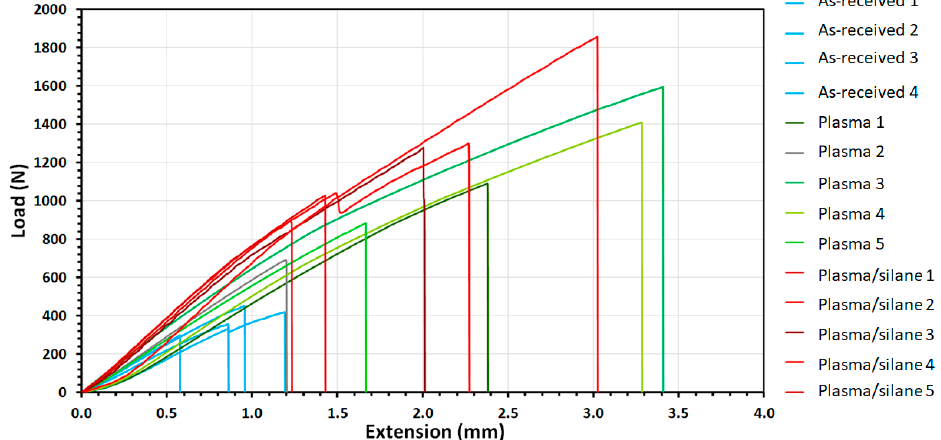
Figure 14. Binding strength as a function of extension of single-joint lap shears made with EPON 825/JEFFAMINE D-230 epoxy resin under different treatment conditions: untreated nylon, after plasma treatment, and after plasma and silane treatments. Multiple samples were tested for each nylon surface